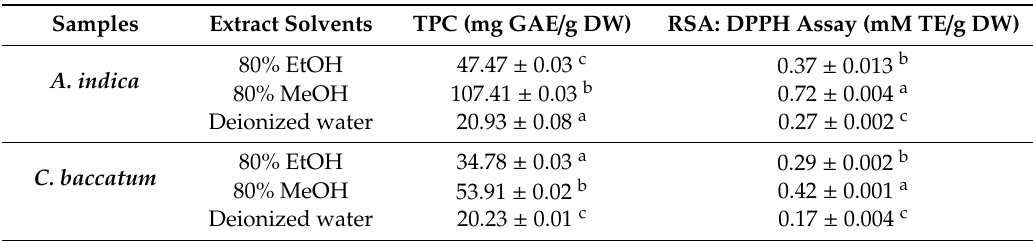
Table 1. Total polyphenol content (TPC) and radical scavenging activity (RSA) of A. indica leaves